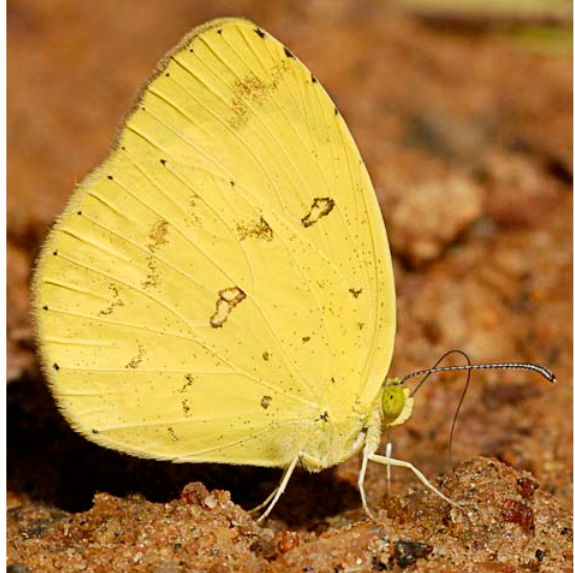
Image 4. Common Grass Yellow Eurema